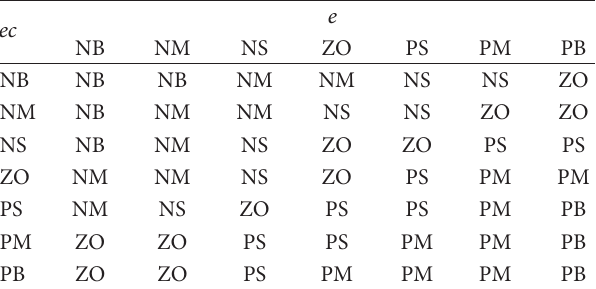
Table 2: Fuzzy logic rule for Δ𝐾 𝐼